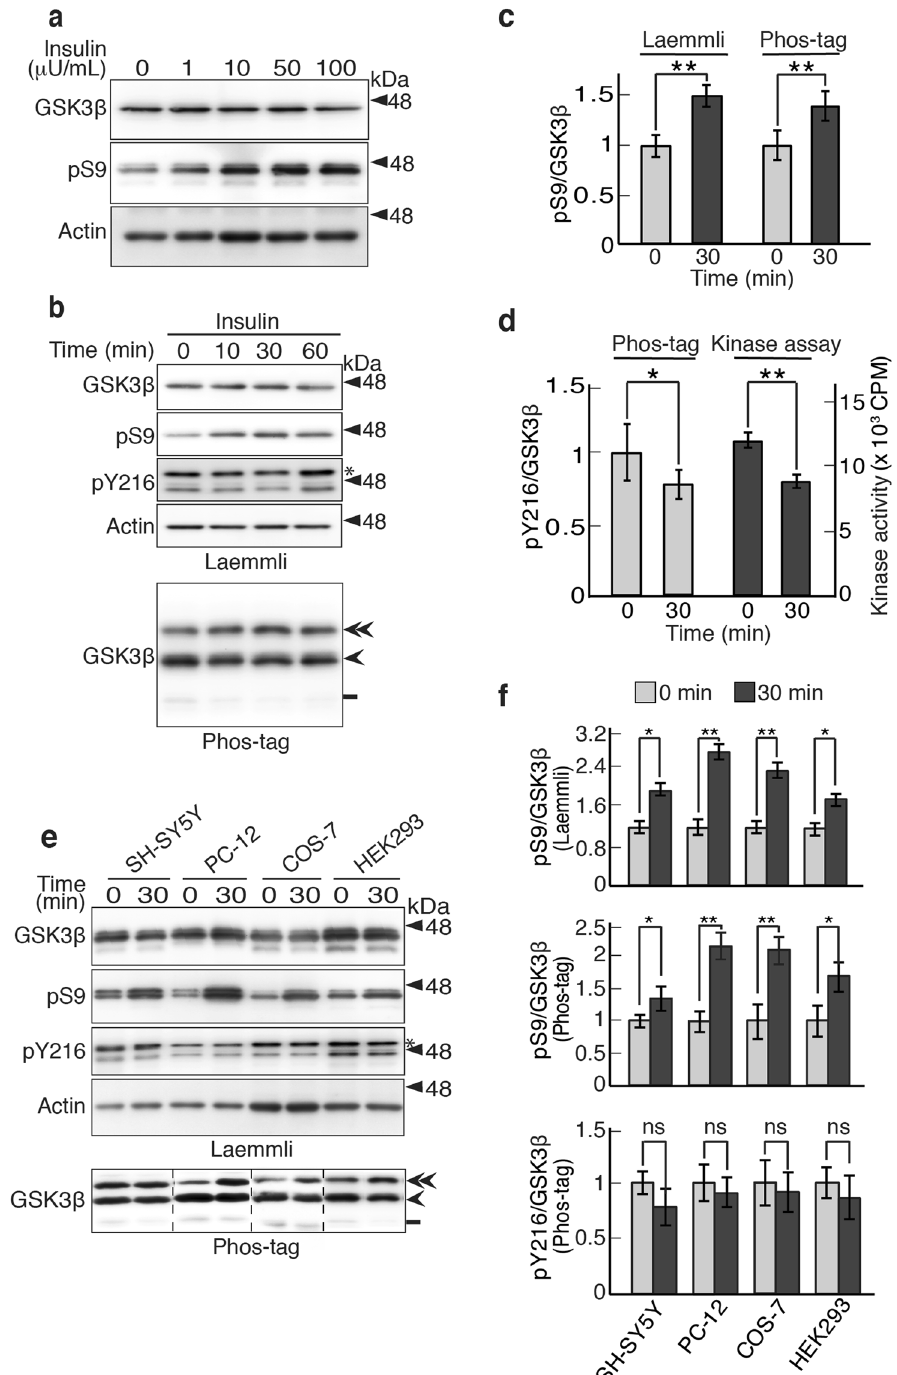
Figure 4. Comparison of GSK3 β activity measured using the kinase assay, the anti-phospho-Ser9 antibody and Phos-tag SDS-PAGE. ( a ) Effect of insulin on Ser9 phosphorylation in HEK293 cells. The cells were treated with 0–100 μ U/ml insulin for 30 min. The lysates were immunoblotted with anti-GSK3 β and phospho-Ser9 (pS9) antibodies. Actin is the loading control. ( b ) Time course of Ser9 phosphorylation of GSK3 β in HEK293 cells treated with 50 μ U/ml insulin for the indicated times. The upper four panels are immunoblots with the indicated antibodies after Laemmli’s SDS-PAGE and the bottom panel shows a Phos-tag immunoblot with anti-GSK3 β . An asterisk in the pY216 blot indicates GSK3 α . Double arrowhead, Ser9/Tyr216-phosphorylated GSK3 β ; arrowhead, Tyr216-phosphorylated GSK3 β ; bar, nonphosphorylated GSK3 β . (c) Quantification of the phospho-Ser9 (pS9) levels. The ratio of the pS9 to total GSK3 β was measured by the anti-phospho-Ser9 reaction on Laemmli’s SDS-PAGE (left) and the phospho-Ser9 band on Phos-tag SDS-PAGE (right) and expressed as the ratio to the control at 0 min. ( d ) Comparison of the phospho-Tyr216 (pY216) levels with the kinase activity of GSK3 β . The ratio of pY216 to total GSK3 β as measured in the lysates of HEK293 cells treated with 50 μ